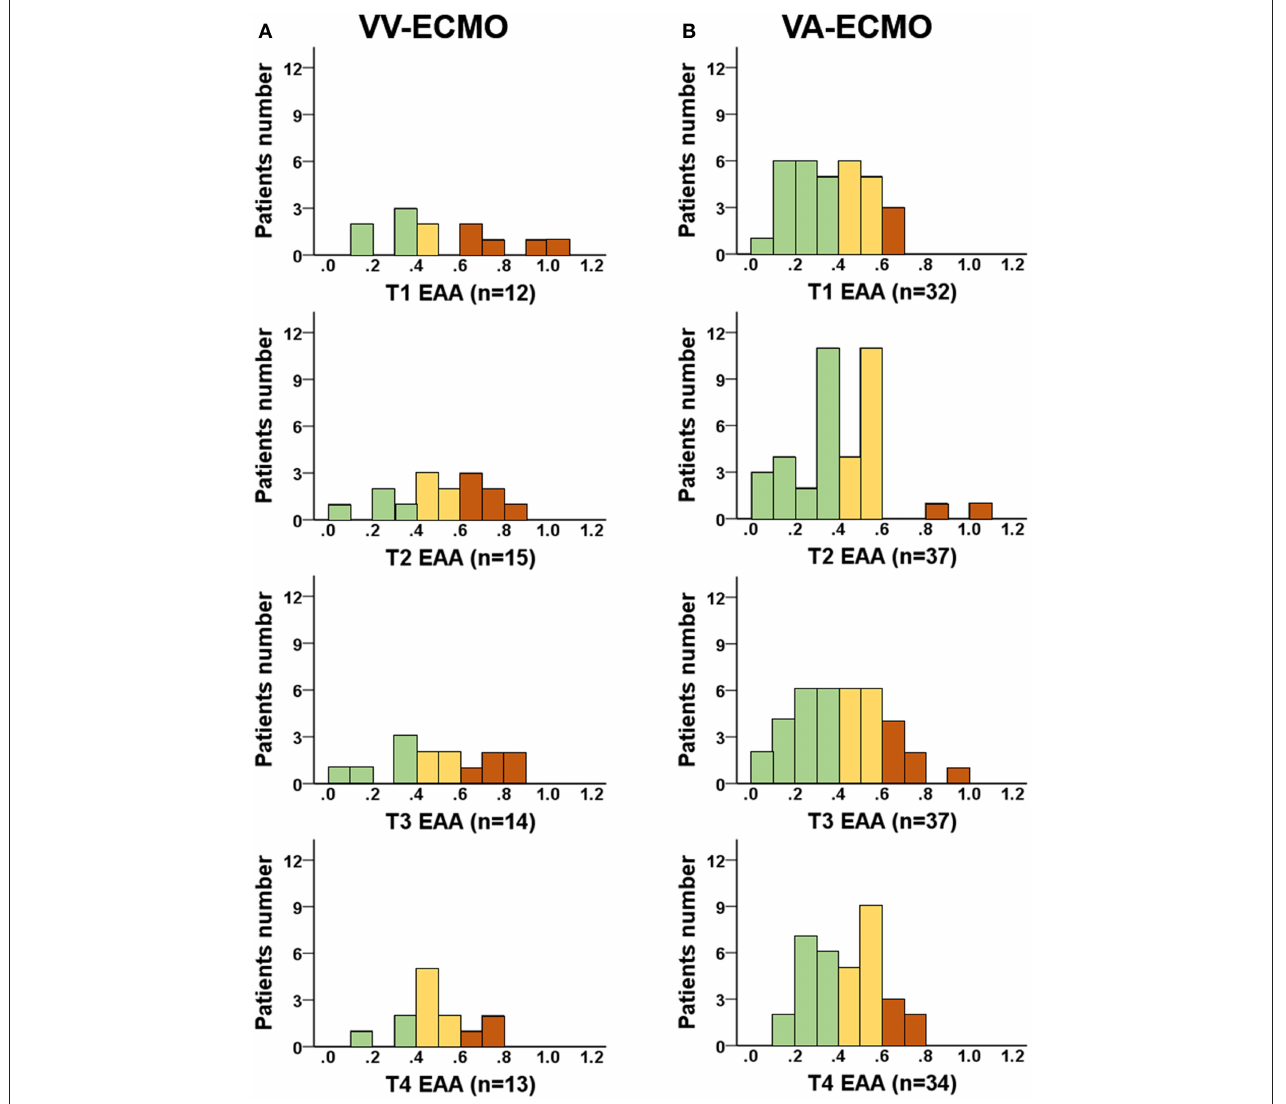
FIGURE 2 | EAA levels in VA-ECMO or VV-ECMO patients. EAA levels were measured at four time points: within 24h (T1) and 25–48 (T2), 49–72 (T3), and 73–96h (T4) after ECMO initiation. (A) EAA levels in VV-ECMO patients; (B) EAA levels in VA-ECMO patients. Brown column stands for high EAA level ( ≥ 0.6); yellow column stands for intermediate EAA level (0.4 to 0.6); green column stands for low EAA level ( < 0.4). EAA, endotoxin activity assay; VA-ECMO, venoarterial extracorporeal membrane oxygenation; VV-ECMO, venovenous extracorporeal membrane oxygenation.